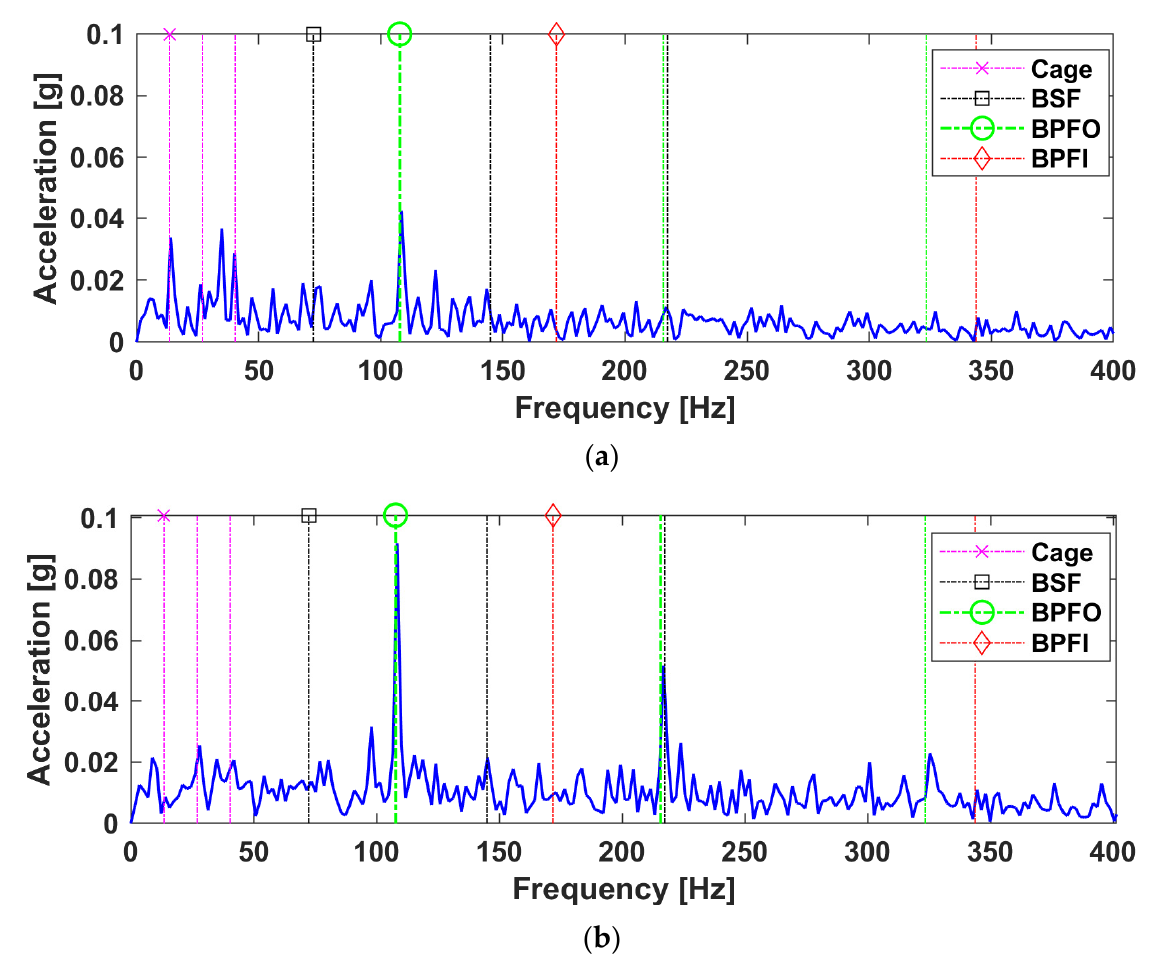
Figure 11. Case B results via LRANTD: ( a ) The amplitude spectrum of TS1 and ( b ) that of TS2.